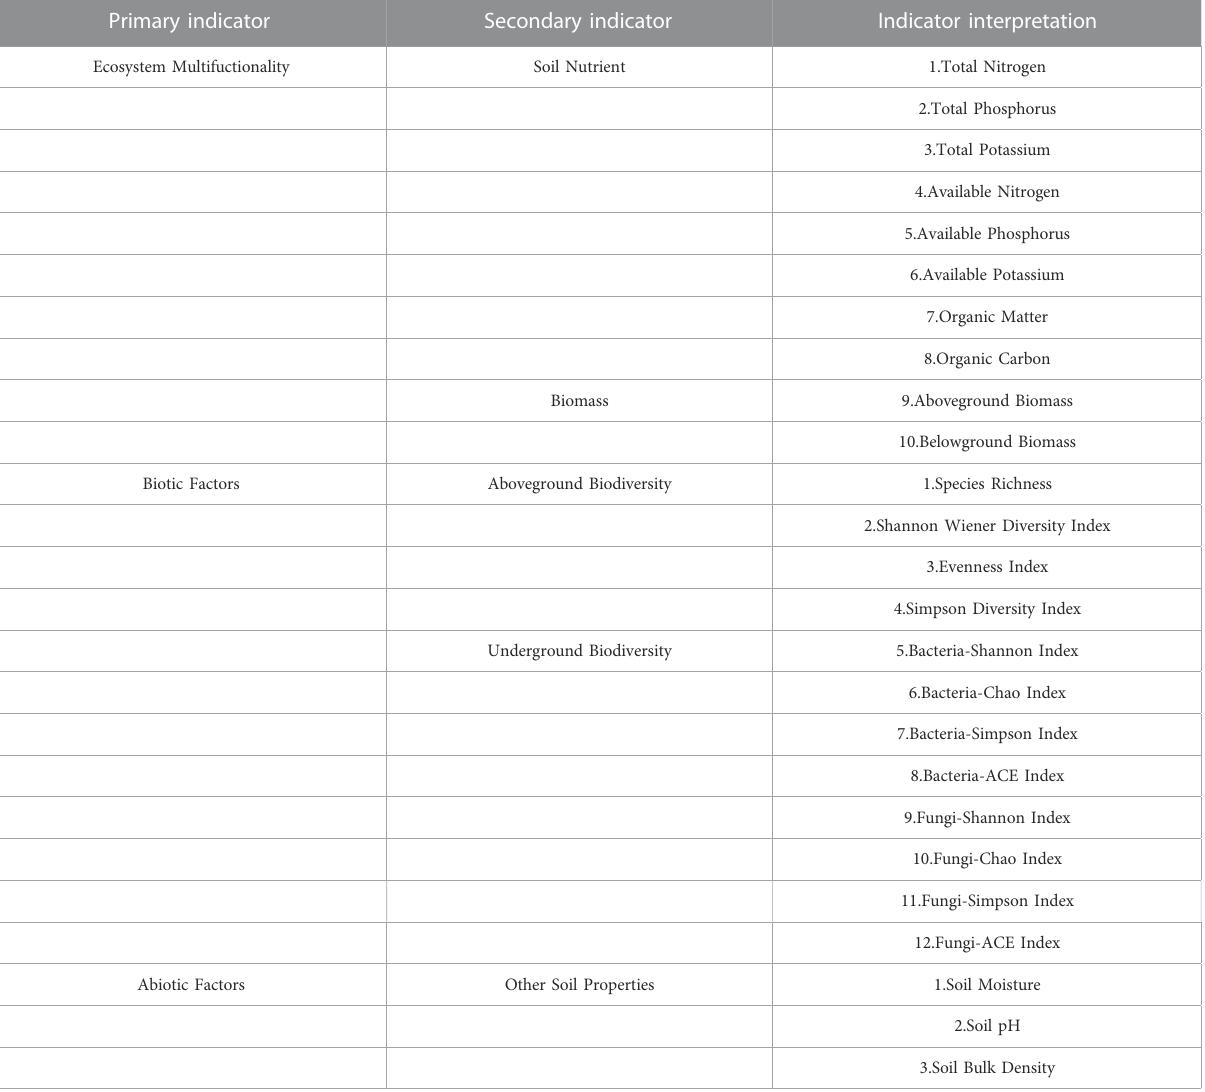
TABLE 3 Plant ‒ soil feedback index